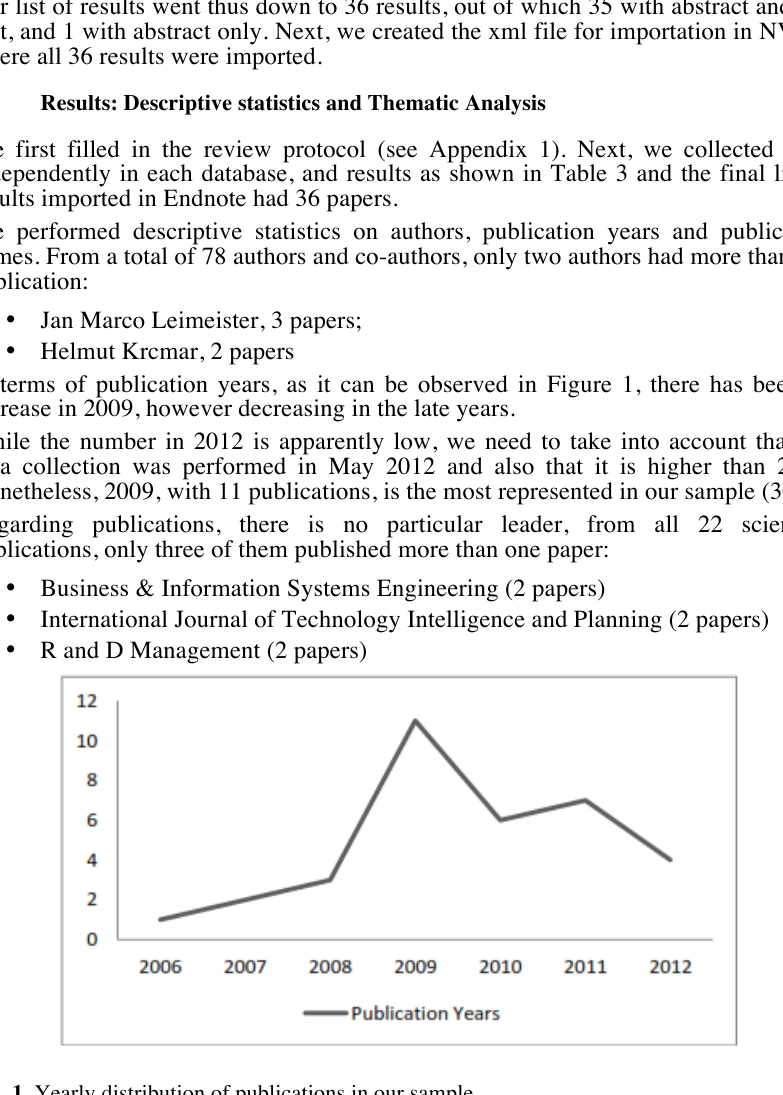
Fig. 1. Yearly distribution of publications in our